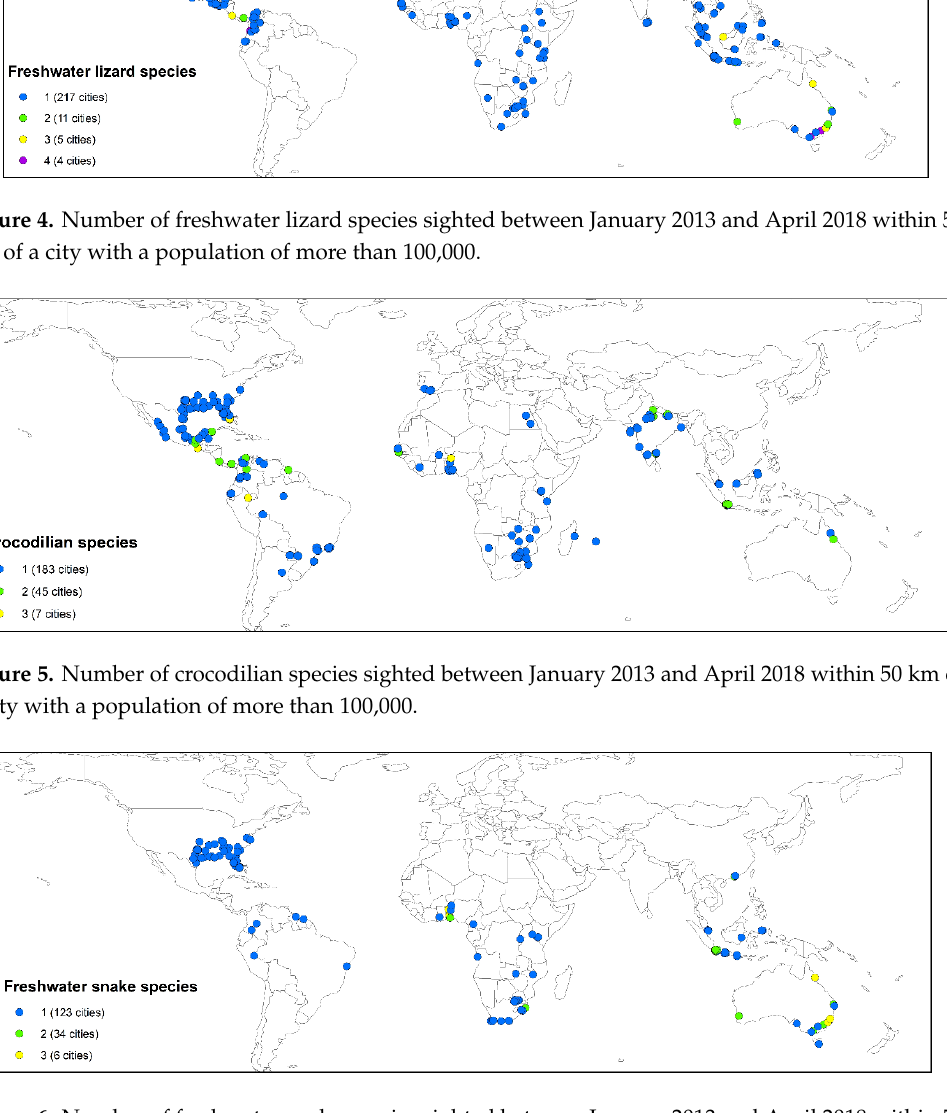
Figure 6. Number of freshwater snake species sighted between January 2013 and April 2018 within 50 km of a city with a population of more than 100,000.